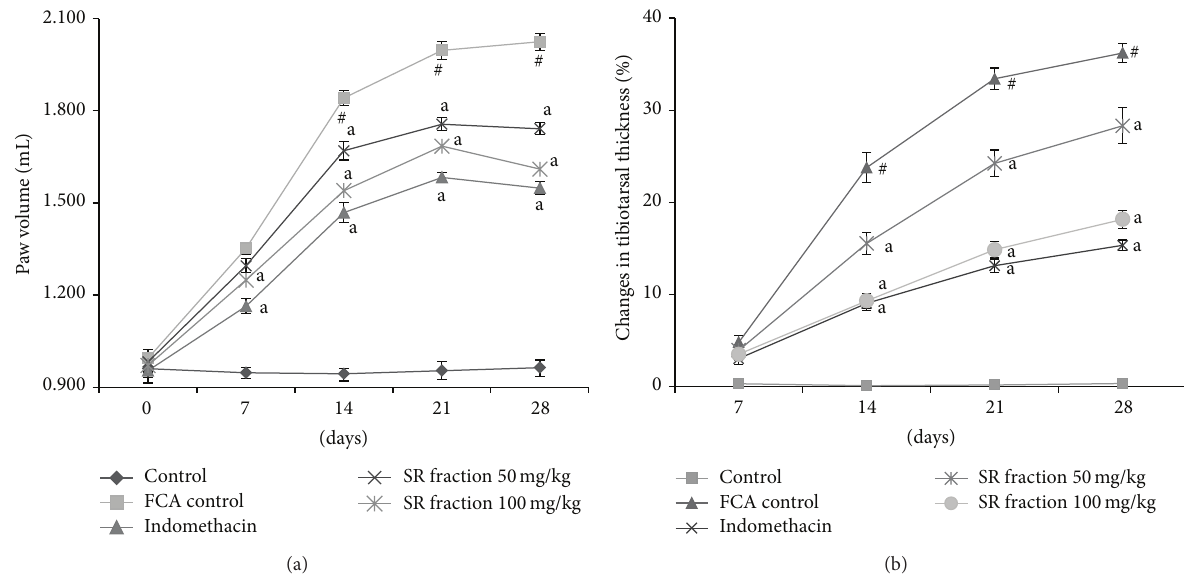
Figure 1: Effect of saponin rich (SR) fraction on (a) paw swelling and (b) % changes in tibiotarsal thickness. All data were expressed as mean ± SEM ( 𝑛 = 6 ). a 𝑃 < 0.05 compared to the FCA control group. # 𝑃 < 0.05 compared with vehicle